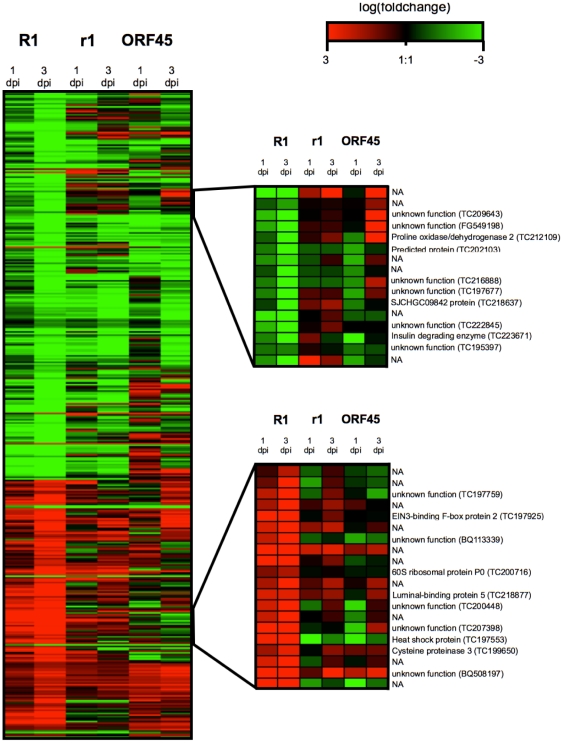
Heat map of the log-fold change values of sample groups R1, r1 and ORF45 at 1 dpi and 3 dpi compared to 0 dpi.Shown is the result of a hierarchical cluster analysis using 406 unitags with significant expression changes in the incompatible interactions (R1) at 3 dpi compared to 0 dpi. Two regions with preferential up or down regulation in the incompatible interaction are shown enlarged with the tag annotation given on the right side. NA: Tag with no matching target sequence.